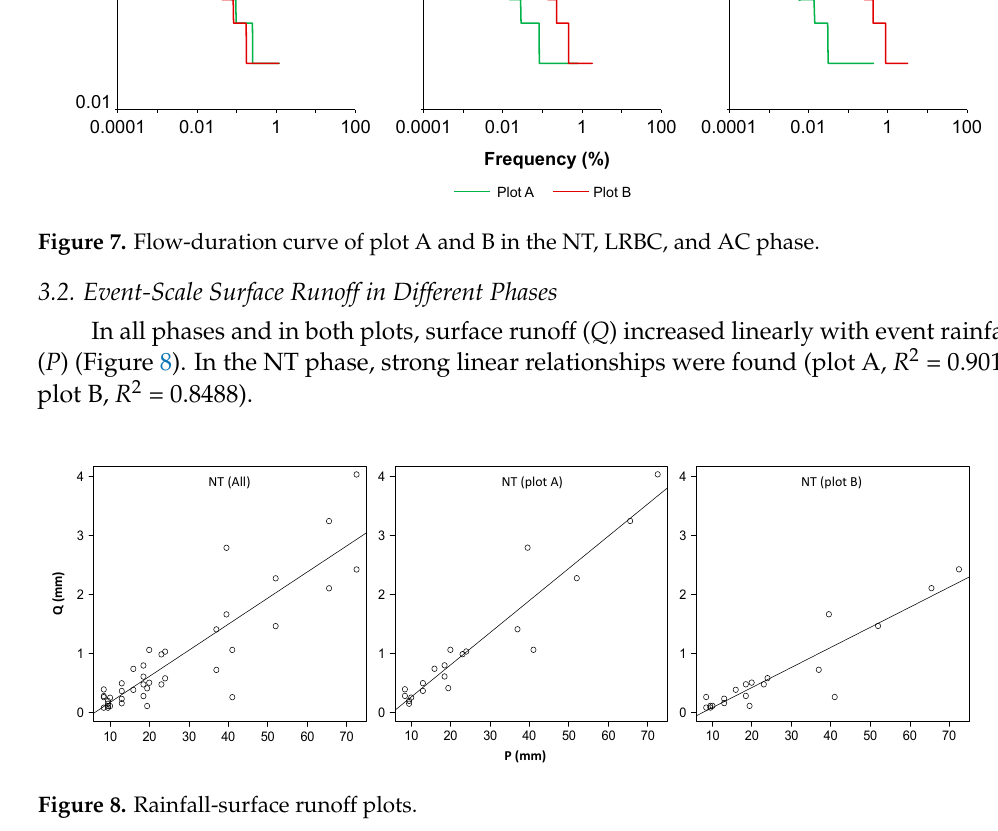
Figure 8. Rainfall-surface runoff plots.